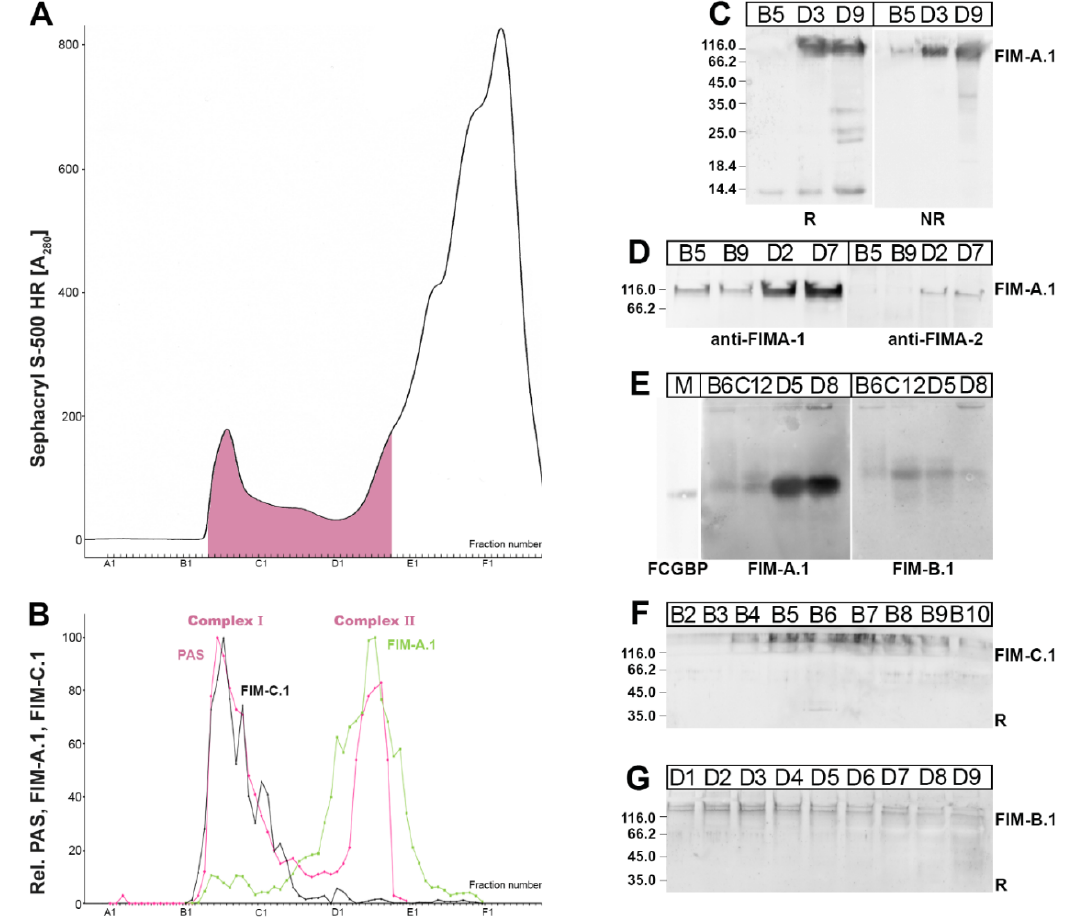
Figure 2. FPLC purification and analysis of FIM-A.1 and FIM-C.1 from a ventral X. laevis skin extract. ( A ) Elution profile after SEC on an S-500 column as determined by absorbance at 280 nm (PAS-positive mucin fractions: pink). ( B ) Distribution of the relative FIM-A.1 (green) and FIM-C.1 content (black) as determined by Western blot analysis under reducing conditions and semi-quantitative analysis of the characteristic ≥ 116,000 band (antiserum anti-FIMA-1) or the >> 116,000 smear (antiserum anti-FIMC-1). The mucin content was semi-quantitatively analyzed using the PAS reaction (pink; Complexes I and II are marked). ( C ) 15% SDS-PAGE under reducing (R) or non-reducing (NR) conditions and subsequent Western blot analysis of the fractions B5, D3, and B9 using anti-FIMA-1. Molecular mass standard: left. ( D ) 15% SDS-PAGE under reducing conditions of the fractions B5, B9, D2, and D7 and Western blot analysis using antiserum anti-FIMA-1 or anti-FIMA-2. ( E ) 1% AgGE of the fractions B6, C12, D5, and D8 and Western blot analysis using anti-FIMA-1 or anti-FIMB-1. Molecular mass standard (M): FCGBP from human colonic mucus. ( F ) 15% SDS-PAGE of fractions B2–B10 under reducing conditions and Western blot analysis using anti-FIMC-1. ( G ) 15% SDS-PAGE under reducing conditions of fractions D1–D9 and Western blot analysis using